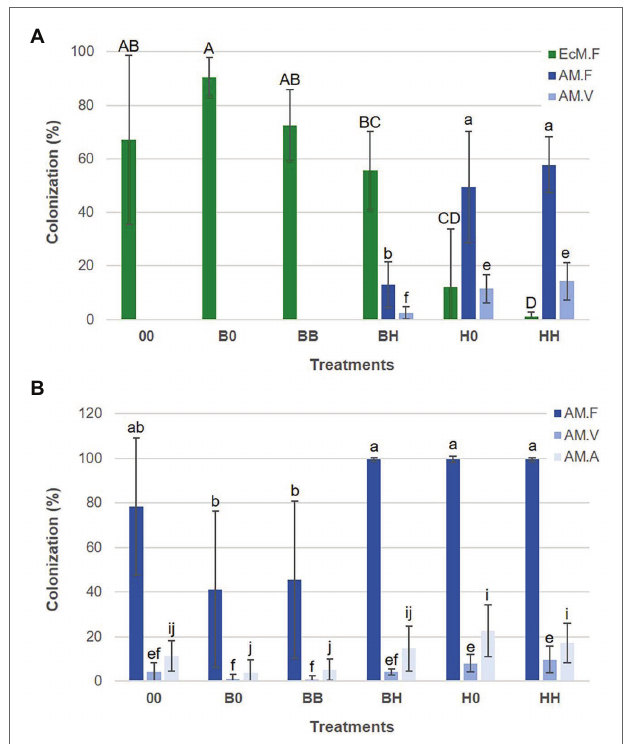
FIGURE 5 | Biomass of B. pendula (A) and H. caespitosum (B) seedlings in middle compartment of each treatment. A logarithmic scale is used on the y-axis. For each variable, significant differences between treatments ( n = 8) are indicated with different letters [uppercase for shoot dry weight (SDW) and lowercase for root dry weight (RDW)]. Treatments: 00 = without plants in lateral compartments, B0 = B. pendula in only one lateral compartment, BB = B. pendula in both lateral compartments, BH = B. pendula and H. caespitosum in lateral compartments (interaction treatment), H0 = H. caespitosum in only one lateral compartment, HH = H. caespitosum in both lateral compartments.